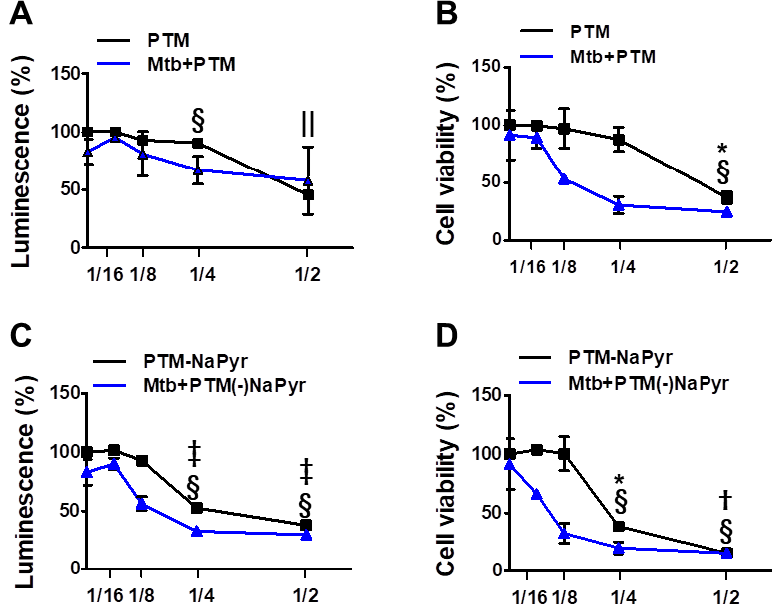
Figure 3. Assessment of ATP-based luminescent cell viability and mitochondrial activity of Mtb - infected (MOI 1) and uninfected cells exposed to PTM at different dilution ratios. ( A – D ) Dose responses of BMDMs to PTM determined using ATP luminescence ( A , C ) and CCK-8 ( B , D ) assays. Cells (5 × 10 3 /well in 96-well plates) were seeded overnight before incubation with PTM. Results are expressed as ratios of ATP-based viable and mitochondrial activities. ( A , B ) PTM, ( C , D ) PTM without NaPyr. PTM or PTM without NaPyr was diluted in media with NaPyr. Data are means ± SEM of at least three independent experiments. Statistical significance was determined for each dose compared with untreated control. ( A – D ) Uninfected cells: * p < 0.05, † p < 0.01, ‡ p < 0.001; Mtb -infected cells: § p < 0.05, and p < 0.001; uninfected vs. infected cells * p < 0.05 and † p < 0.01.